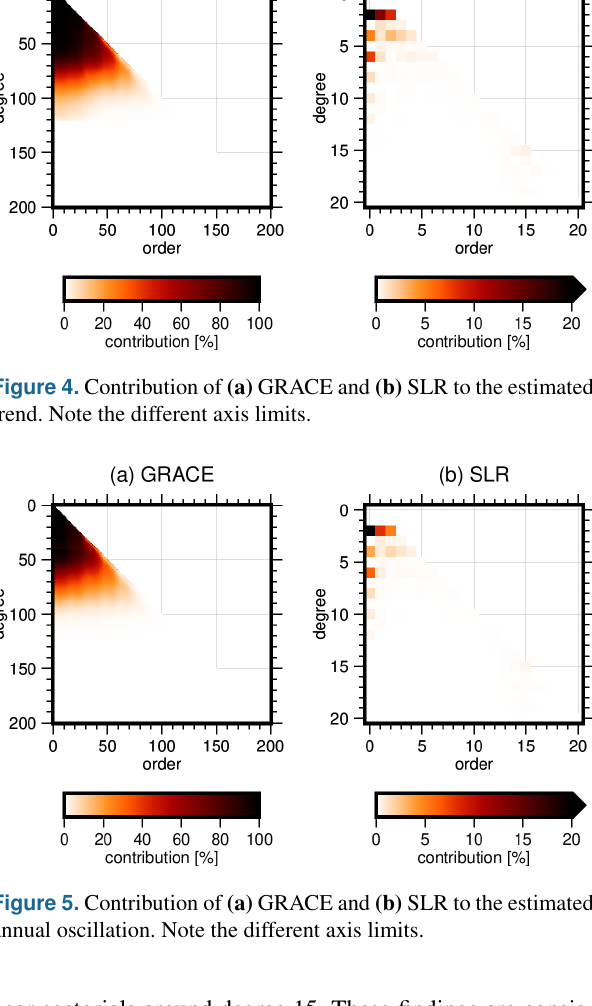
Figure 3. Individual contribution to the static part of the estimated potential coefficients for (a) GRACE, (b) GOCE SGG, (c) Kaula regularization, (d) LEO orbits and (e) SLR. Note the different axis limits for panels (d) and (e) .